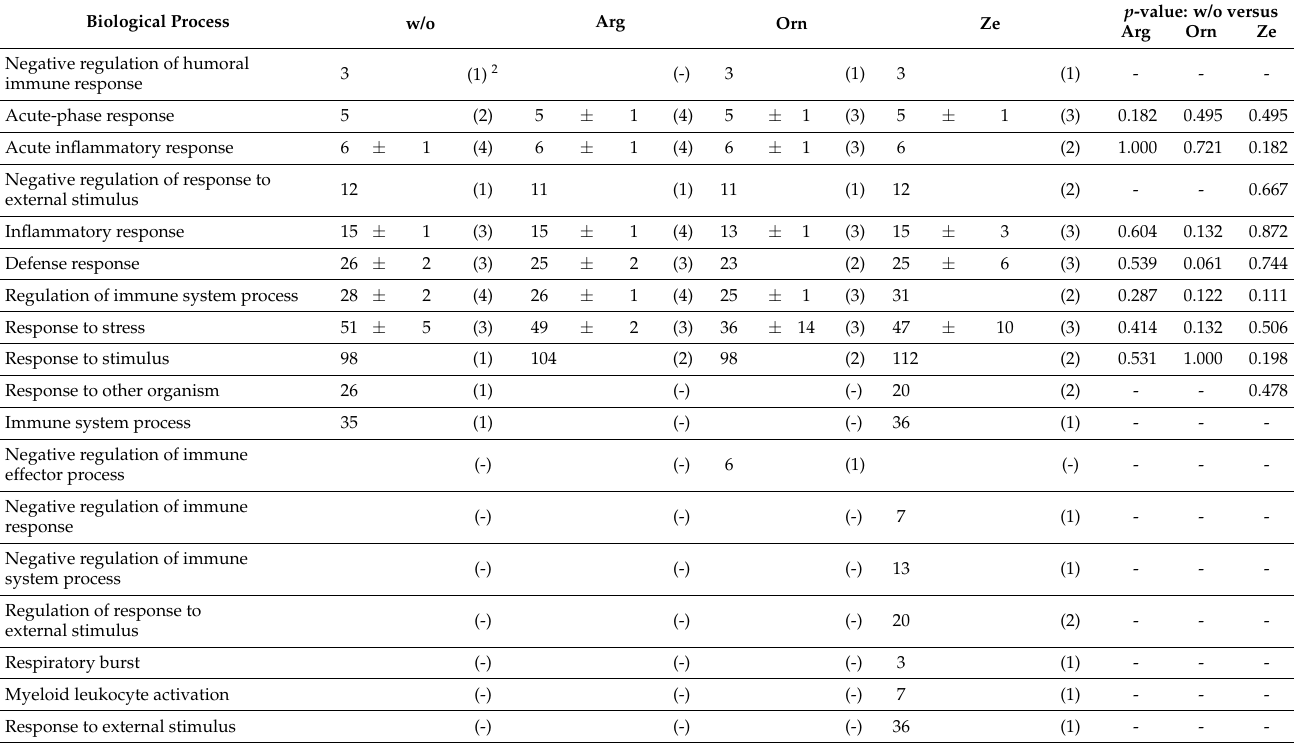
Table 1. Urinary proteins associated with biological processes 1 related to the immune/stress re- sponse, detected in the urine of cats ( n = 4) fed a high-protein diet without (w/o) or with the supple- mentation of arginine (Arg), ornithine (Orn) or zeolite (Ze). Mean number of proteins ±standard deviation.